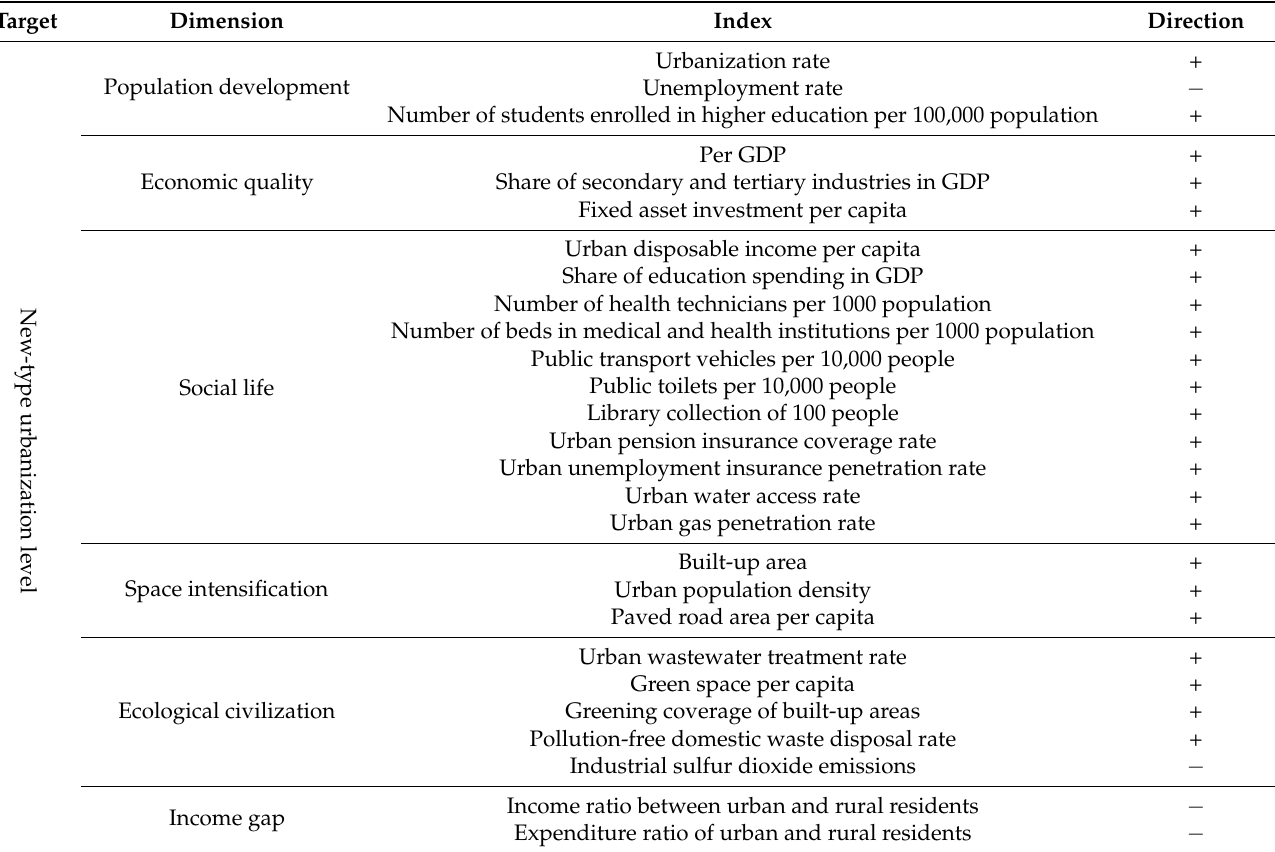
Table 1: population development, quality of the economy, ecological civilization, people’s quality of life, spatial intensification, and urban–rural integration. Table 1. New urbanization development level index